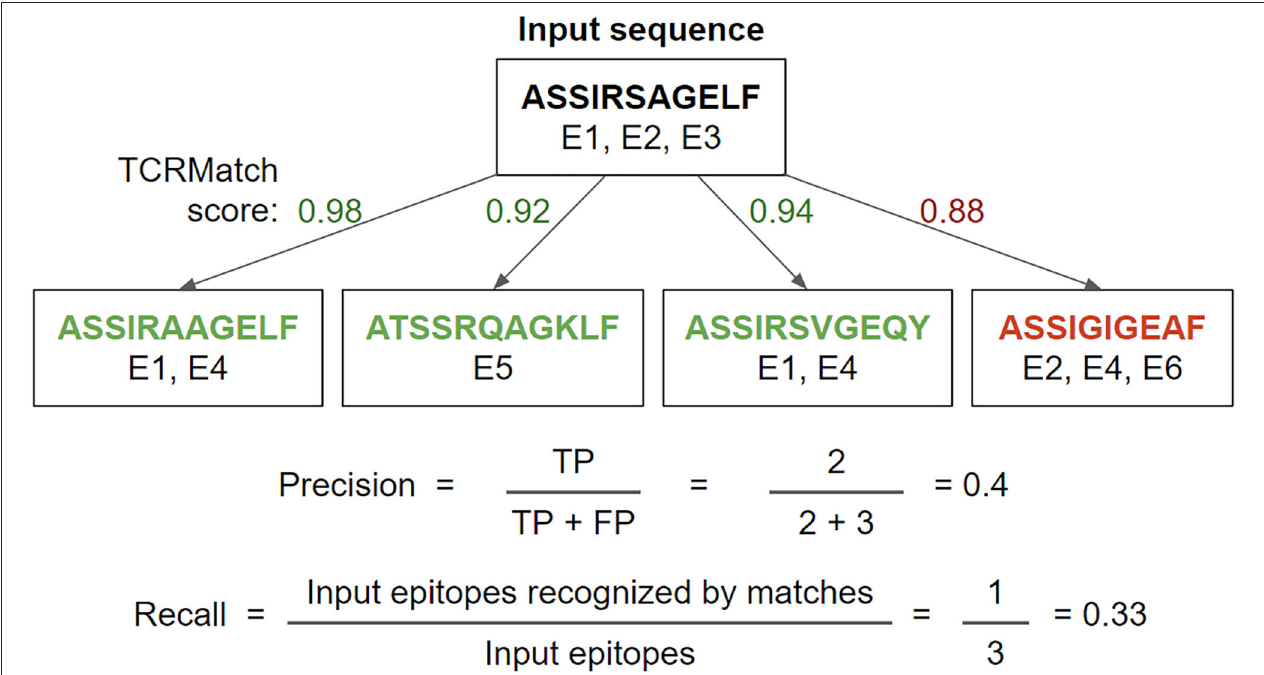
FIGURE 1 | Example precision and recall calculation. Using a TCRMatch score cutoff of 0.9, the input sequence matches 3 out of 4 tested sequences. Of the 5 epitopes recognized by the 3 matches, 2 epitopes (E1, E1) are shared with A (true positives, TP) and 3 epitopes (E4, E5, E4) are not shared with A (false positives, FP), resulting in a precision of 2/5. Of the input sequence’s three epitopes (E1, E2, E3), E1 is also recognized by the first and third match, while E2 and E3 are not recognized by any of the matches; therefore, recall = 1/3.